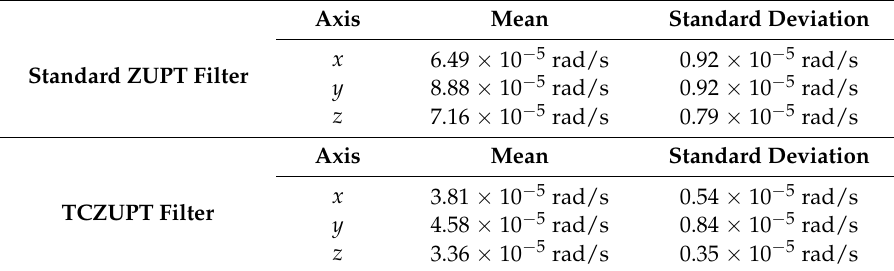
Table 11. Mean and Standard Deviation (residual error of 15 degree/h, 5 data sets).